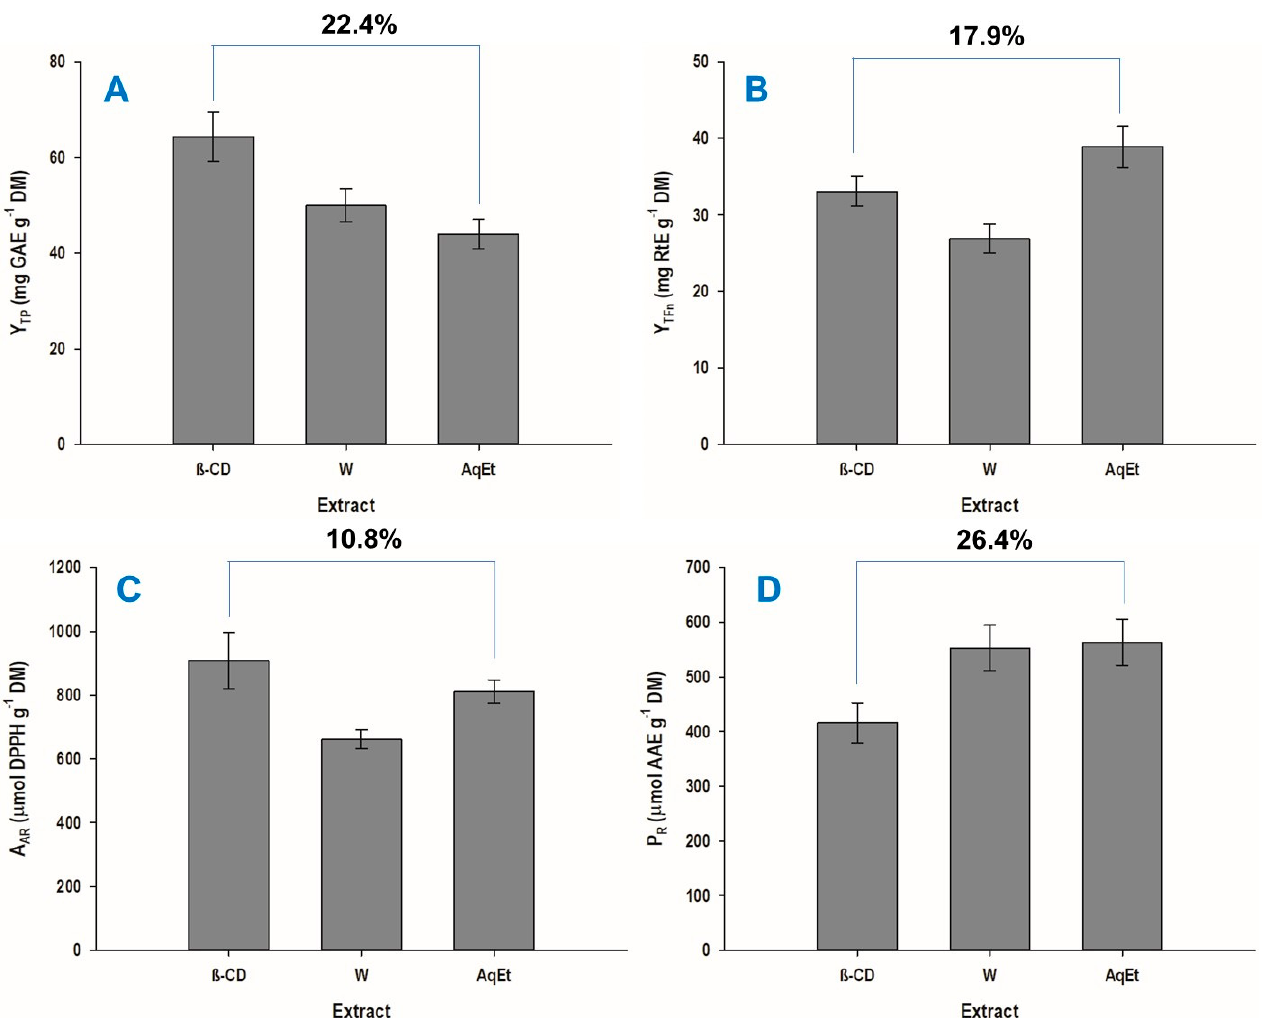
Figure 3. Comparison of the effectiveness of the β -CD-aided extraction with 60% aqueous ethanol